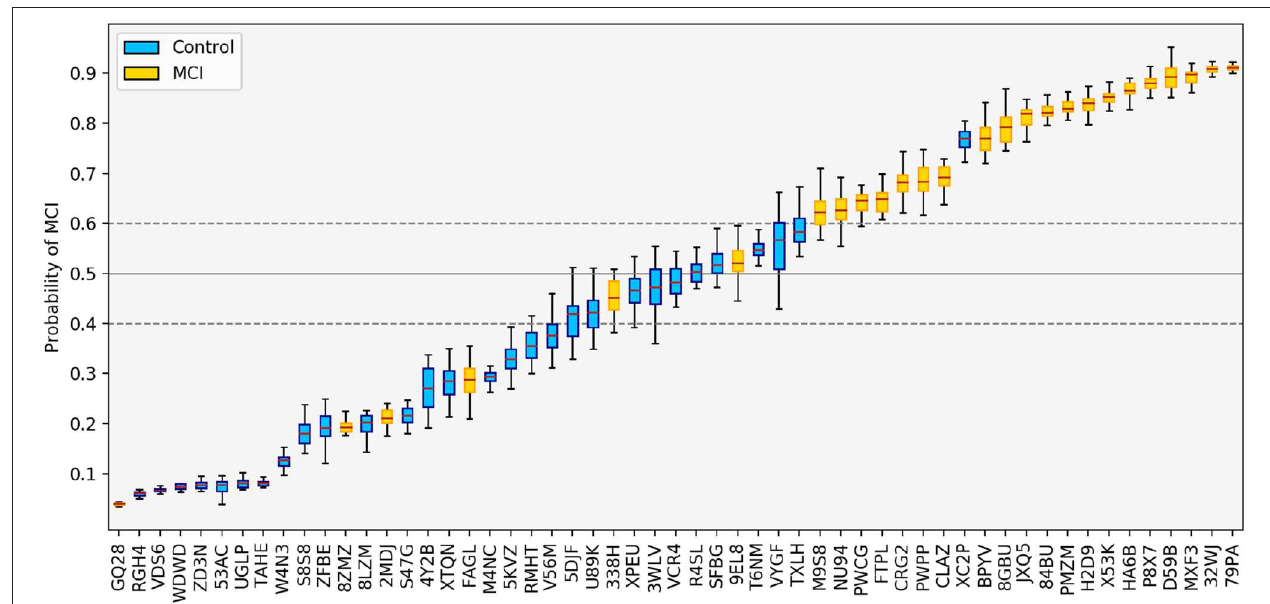
FIGURE 5 | Predictions made by the LR classifier using feature fusion, averaged across all test folds. The solid gray line indicates the default threshold of 0.5. By changing the threshold, we can adjust the sensitivity and specificity of the classification; e.g., if the threshold is increased to 0.6 (upper dashed line), only one control is mis-classified as MCI; if the threshold is decreased to 0.4 (lower dashed line), only four MCI patients are